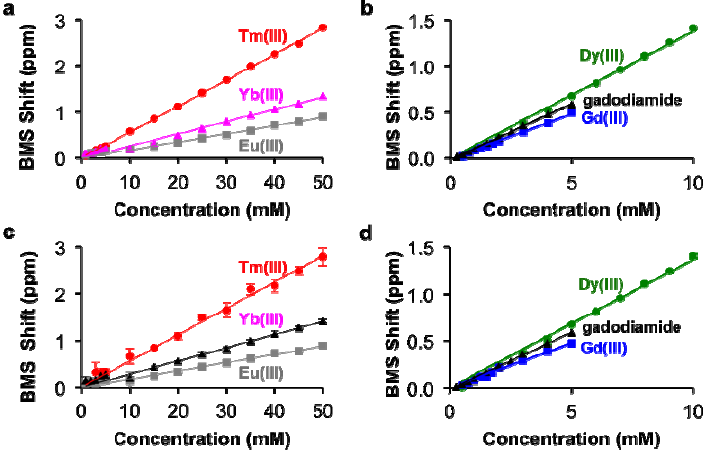
Figure 5. Correlation of BMS shift and concentration of lanthanide ion or gadodiamide in ( a , b ) rat kidney tissues and ( c , d ) rat liver tissues showed outstanding linearity with R 2 >